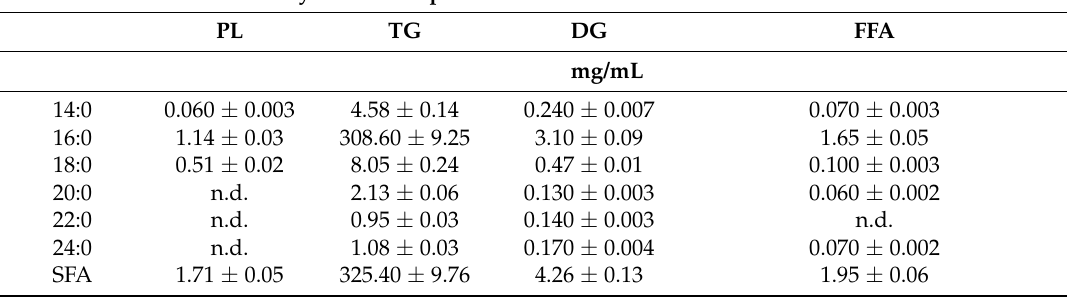
Fatty Acids Composition of Sea Buckthorn Needs